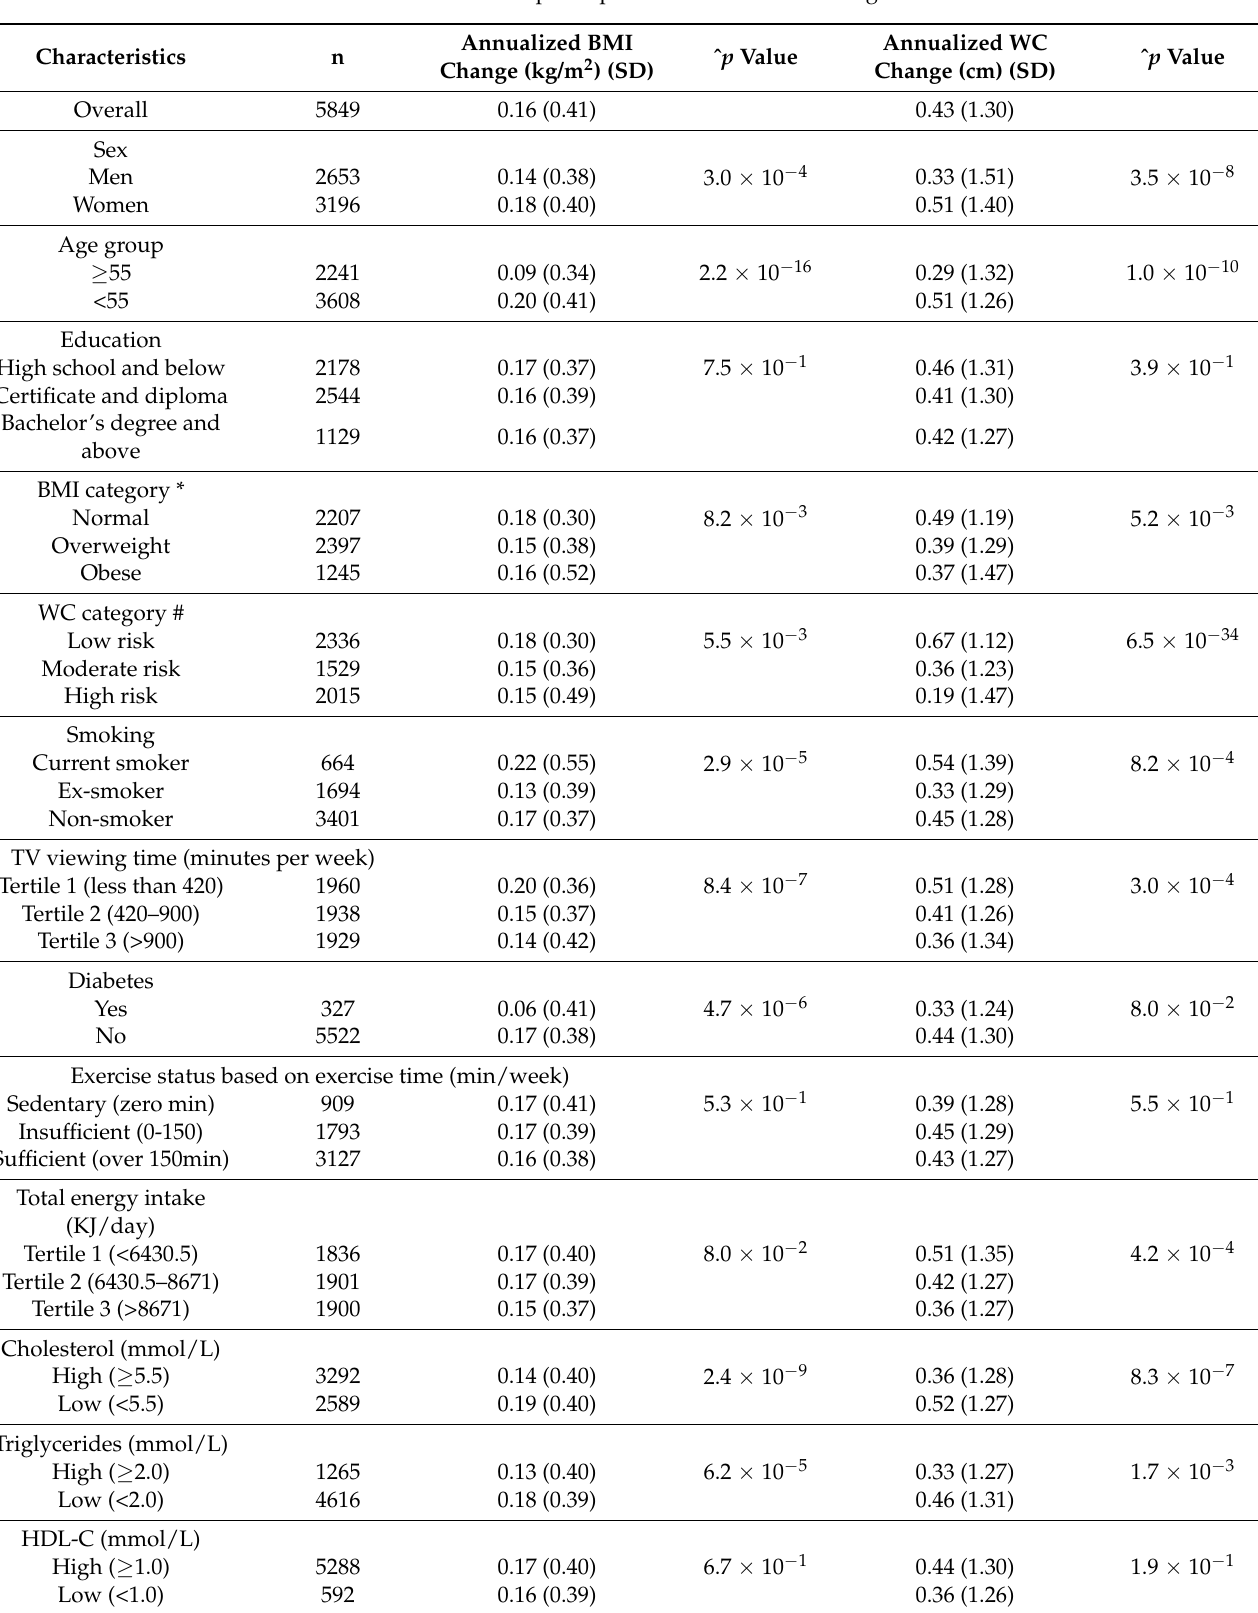
Table 1. Baseline characteristics of participants associated with changes in WC or